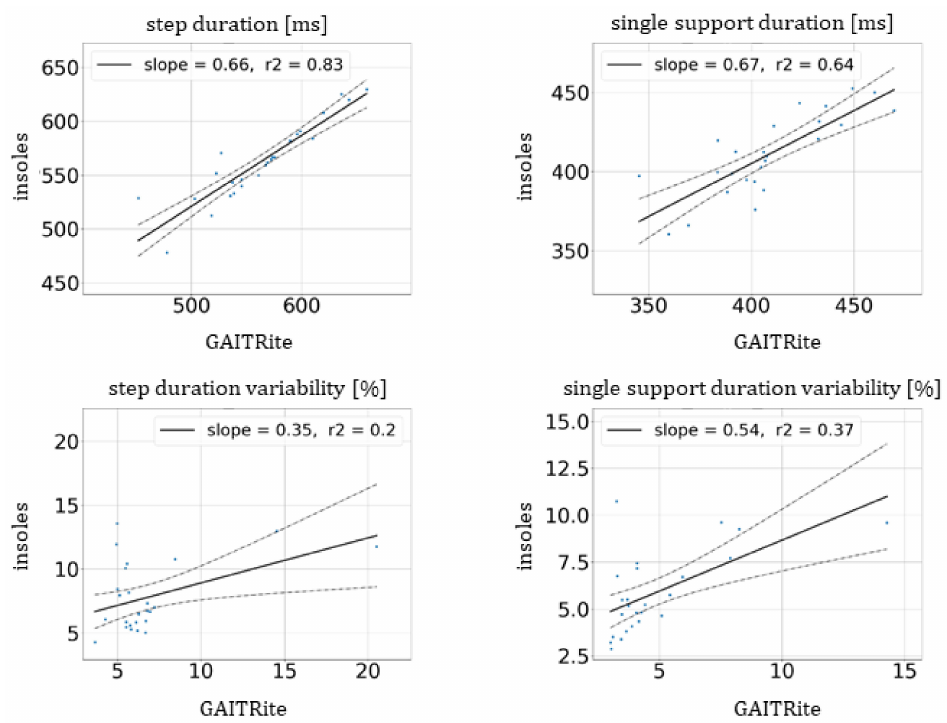
Figure 5. Linear regression of average estimates and estimates of variability of bipedal gait parameters with step duration and single support duration between GAITRite ® mat and the insoles (solid lines). The dashed lines represent the confidence region. The values of the slope and the coefficient of determination, r 2 , are provided in the